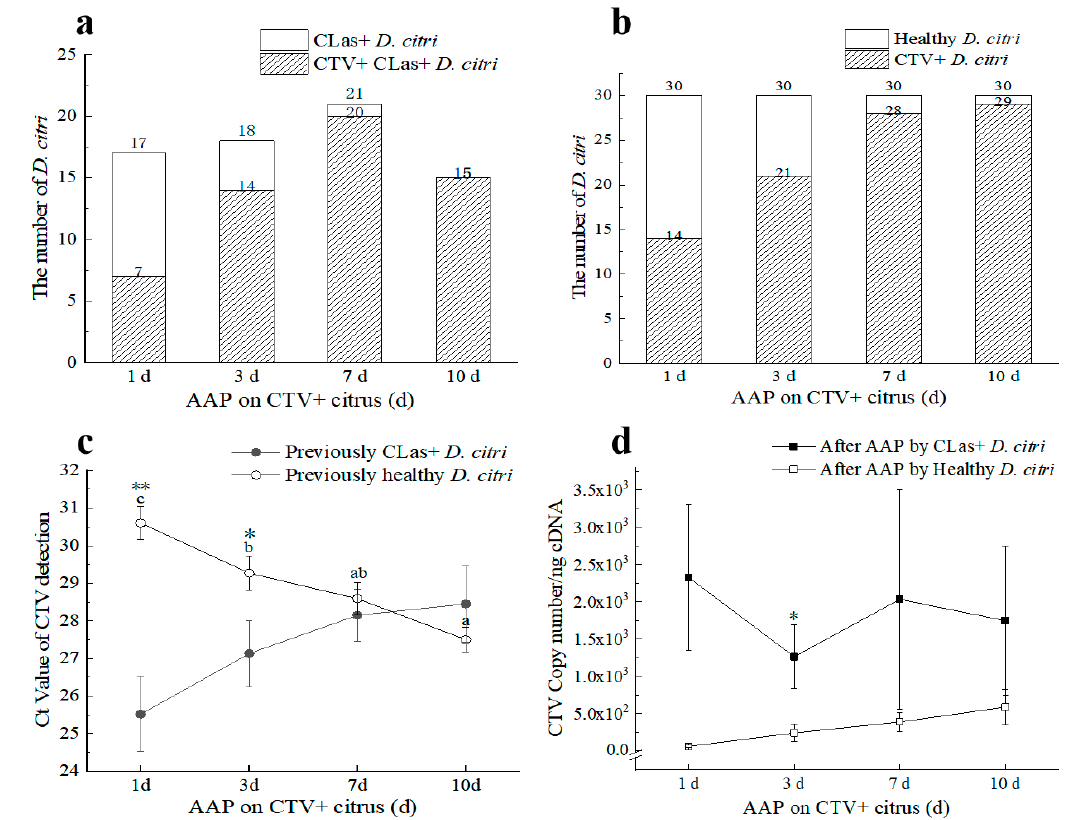
Figure 4. Effects of ‘ Candidatus Liberibacter asiaticus’ (CLas) and Citrus tristeza virus (CTV) acquisition by different D . citri collected from CTV+ Citrus grandis Osbeck at 1–10 days after acquisition access period (AAP) in laboratory conditions. ( a ) The number of CTV-carrying D . citri after AAP of CLas+ D . citri population; ( b ) The number of CTV-carrying D . citri after feeding by healthy D . citri at different days’ AAP; ( c ) Ct values (mean ± SE) of CTV+ D . citri after different time’s AAP on CTV+ citrus by previously CLas+ or CLas − D . citri adults; ( d ) CTV titers in CTV+ D . citri of different AAP time by previously CLas+ or CLas − D . citri . CLas+: CLas positive; CTV+: CTV positive. Different letters in the figure indicate significant differences at p < 0.05 level by one–way analysis of variance (ANOVA) followed by Duncan’s new multiple range test. * or **: Independent sample t -test or Duncan’s Multiple range test was used to determine statistical significance in 95% confidence interval ( p = 0.05) or 99% confidence interval ( p = 0.01).